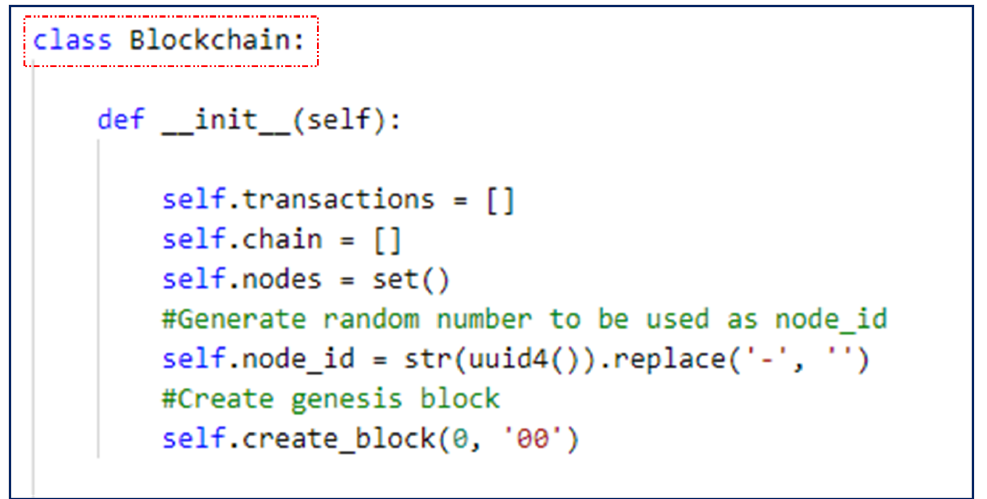
Figure A4. Construction of